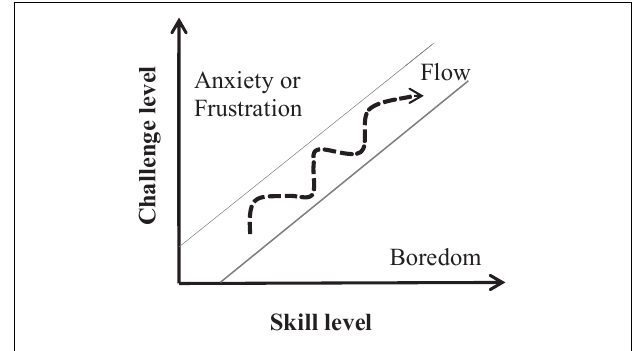
FIGURE 1 | The flow-channel model (Csikszentmihalyi,